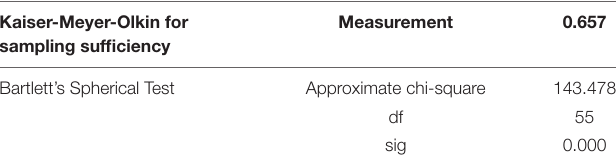
TABLE 3 | KMO and Bartlett’s Spherical tests.